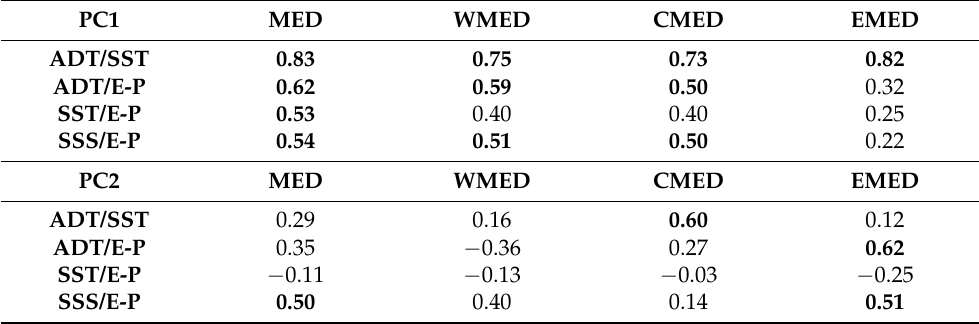
Table 2. Correlation coefficients (95% confidence level) between the PC1s and PC2s of the independent variables considered in the Mediterranean Sea and in its sub-basins. Correlation ≥ 0.5 are emphasized in bold in the table and described in the text.